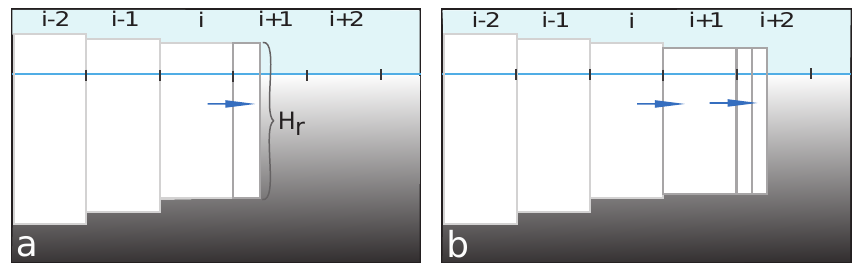
Fig. 3: (From Albrecht et al., 2011) Schematic diagram illustrating subgrid-scale advance of the calving front. As a new grid cell i + 1 is partially filled with ice its ice thickness is kept constant at the same value as grid cell i .